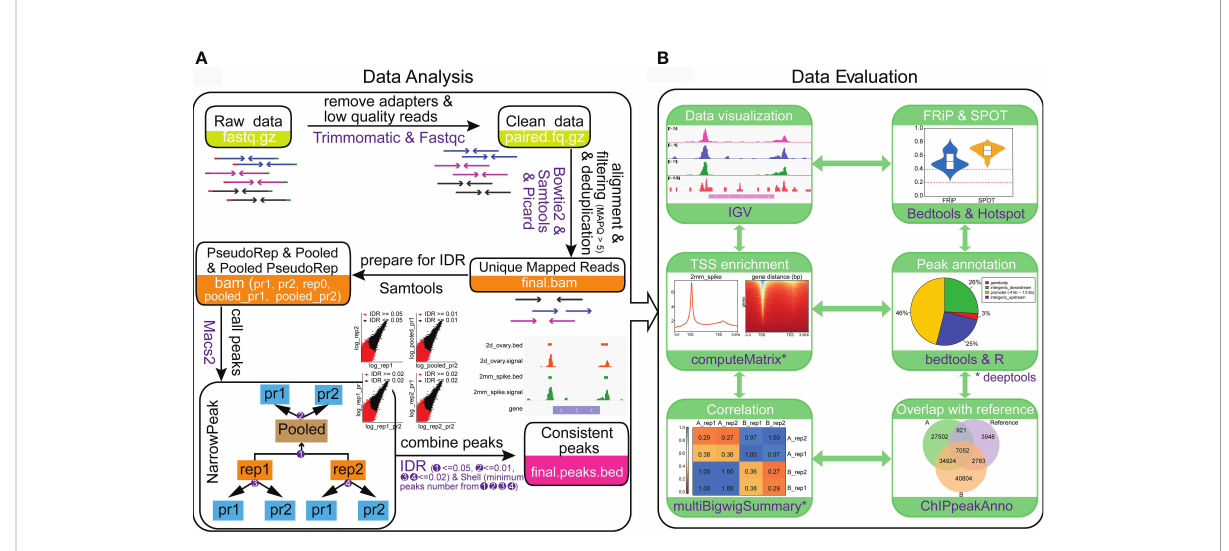
FIGURE 4 Protocol for ATAC-seq data analysis and data quality evaluation. (A) Steps for ATAC-seq data analysis of wheat. (B) Processes and metrics to evaluate the data quality of ATAC-seq. The results were generated from the young spike and ovary samples with two biological replications. A_rep1 and A_rep2 represent the two replications from young spike. B_rep1 and B_rep2 are the two replications from ovary. The reference in the venn diagram represents the open chromatin regions obtained from GSM3564343.